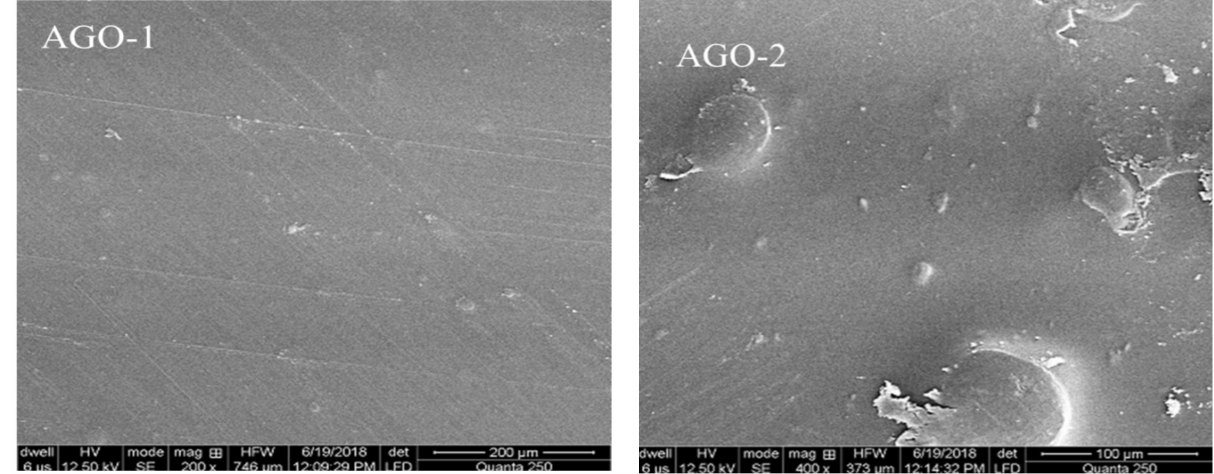
Figure 5. SEM images of surface morphology of AGO membranes.